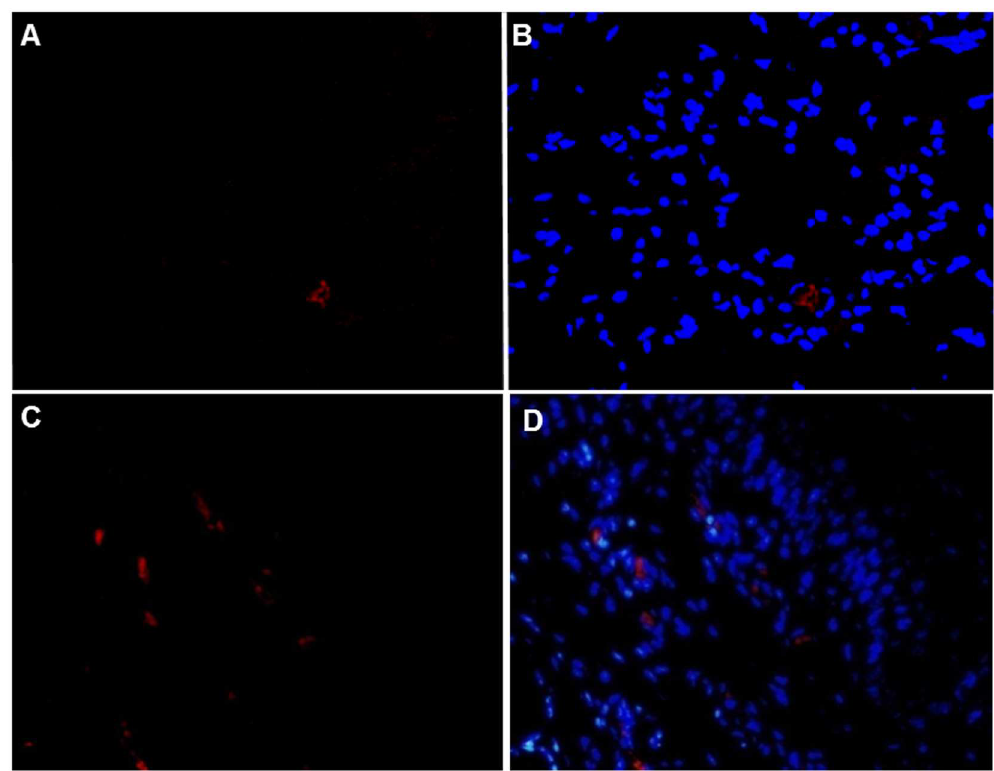
Fig 3. FMDV antigen detection by multi-channel immunofluorescencetechnique. (A) FMDV antigen(red) in few cells in lungs of aborted fetus from Dam ID#454 by indirect fluorescence assay (IFA). (B) Same image as shown in panel (A) mergedwith nuclearstaining by DAPI (blue). (C) FMDV antigen(red) subjacentto basal epithelialcells in dorsal soft palate of aborted fetus. (D) Same image shown in panel (C) merged with nuclear staining by DAPI (blue). Rabbit anti-FMDV serotype O and rodamine-conjugatedgoat anti-rabbit.40x